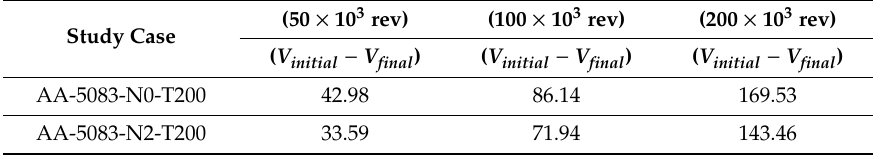
Table 1. Loss of volume (mm 3 ) during the wear tests, where the expanded uncertainty values are U (k=2) = 0.05 mm 3 for all cases.